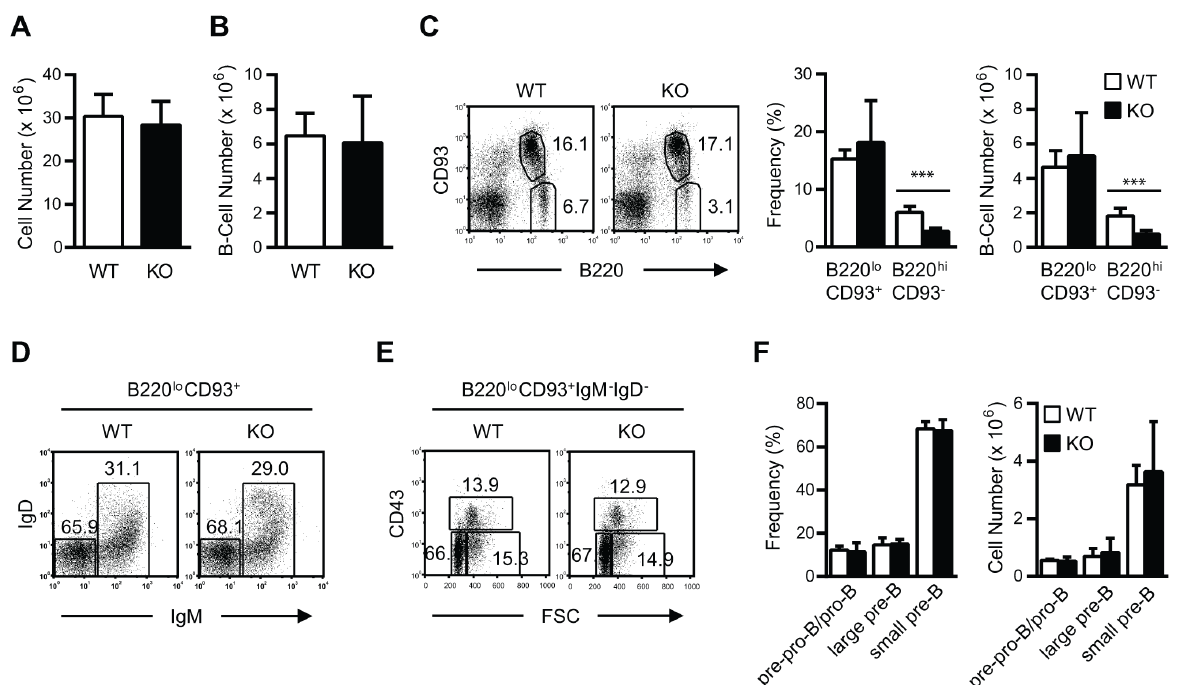
Fig 1. Effect of TSC1 deficiency on B cell development in the bone marrow. (A, B) Two-month-old WT and TSC1KO mice were euthanized to assess B cell development. BM total cellularity (A) and total B220 + B cells (B) (n = 8). (C) Decreased B220 high CD93 - B cells in TSC1KO BM. Dot plots show representative CD93 and B220 staining of live-gated BM cells. Bar graphs represent mean ± SEM of percentages (middle) and absolute numbers (right) of indicated B cell compartments (n = 8). (D-F) Normal early B cell development in TSC1KO mice. (D) IgM and IgD staining of gated CD93 + B220 low cells from BM. (E) CD43 staining and FSC assessment of gated CD93 + B220 low IgM - IgD - BM cells. (F) Frequencies (% of CD93 + B220 low IgM - IgD - B cells) and absolute numbers of pre-pro-B/pro-B, large pre-B, and small pre-B cells. Pre-pro-B/pro-B cells, CD93 + B220 low IgM - IgD - CD43 + FSC int ; large pre-B, CD93 + B220 low IgM - IgD - CD43 int FSC high ; small pre-B, CD93 + B220 low IgM - IgD - CD43 - FSC low (n = 8). Data shown represent or are calculated from at least four experiments. Two pairs of WT and TSC1KO mice received BrdU prior to analysis. *** p < 0.001 determined by Students ’ t